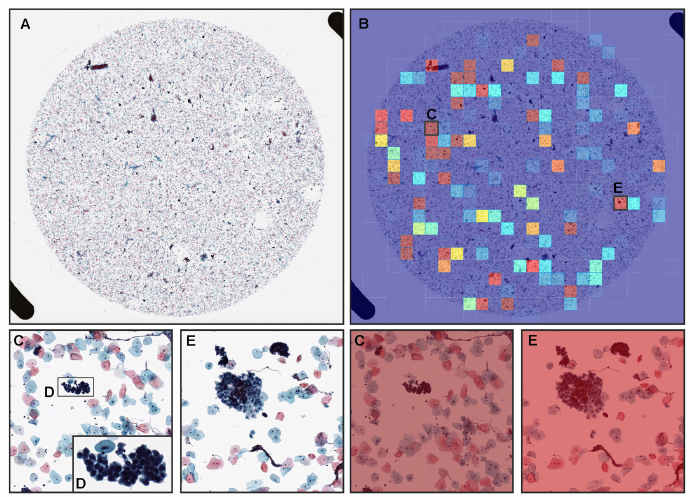
Figure 6. A representative example of neoplastic false positive prediction outputs on a liquid-based cytology (LBC) case from test sets. Cytopathologically, ( A ) is a NILM (negative for intraepithelial lesion or malignancy) whole-slide image (WSI) of LBC specimen. The heatmap image ( B ) exhibited false positive predictions of neoplastic tiles ( C , E ). In ( C ), there are parabasal cells with a slightly high nuclear cytoplasmic (N/C) ratio with dense chromatin appearance due to the cellular overlapping ( D ). In ( E ), there are cell clusters of squamous epithelial cells and cervical gland cells with slightly high N/C ratios and a dense chromatin appearance due to the cellular